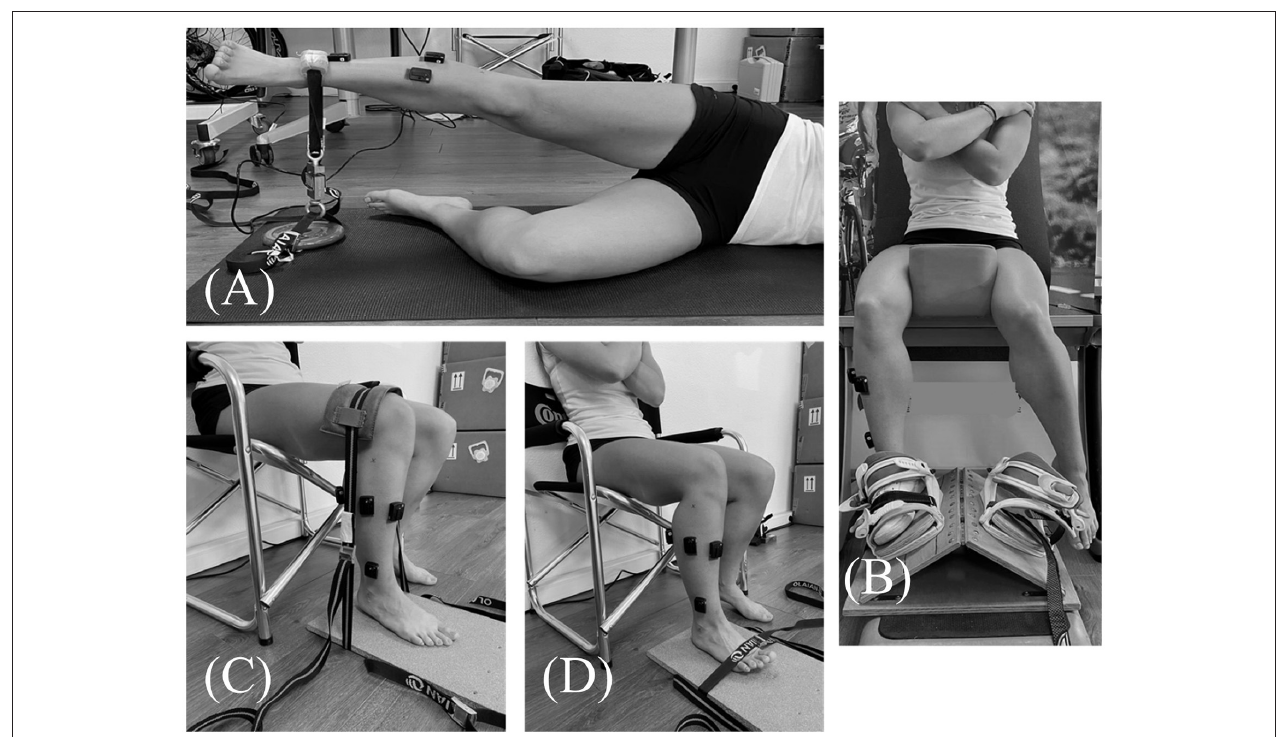
FIGURE 2 | Maximal voluntary isometric contraction of (A) Gluteus medius, (B) Peroneus longus and brevis, (C) Gastrocnemius lateralis, (D) Tibialis anterior.